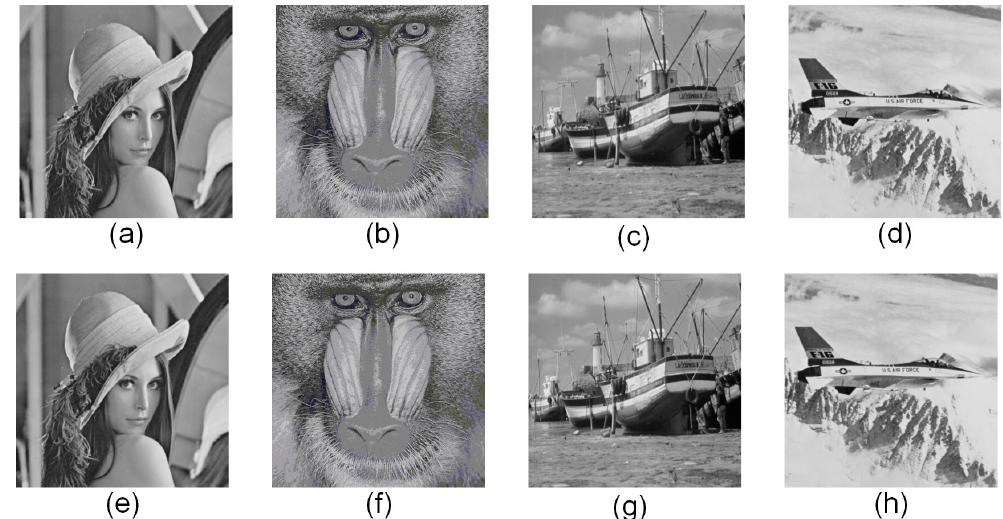
Figure 8. ( a – d ) The four original standard gray-scale images of size 512 × 512; and ( e – h ) the directly decrypted images (DDI) to check embedding rate, peak signal noise ratio (PSNR), structural similarity index matrix (SSIM) for different images in our scheme. Table 2. Embedding rate, peak signal noise ratio (PSNR), structural similarity index matrix (SSIM) for four distinct standard test images (Figure 8a–d) in the proposed scheme. Test Images